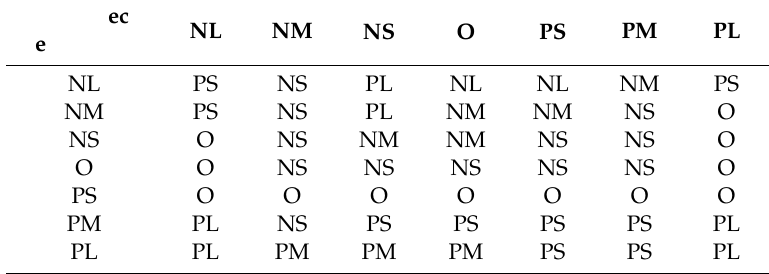
Table 4. The fuzzy table of ∆ K D .